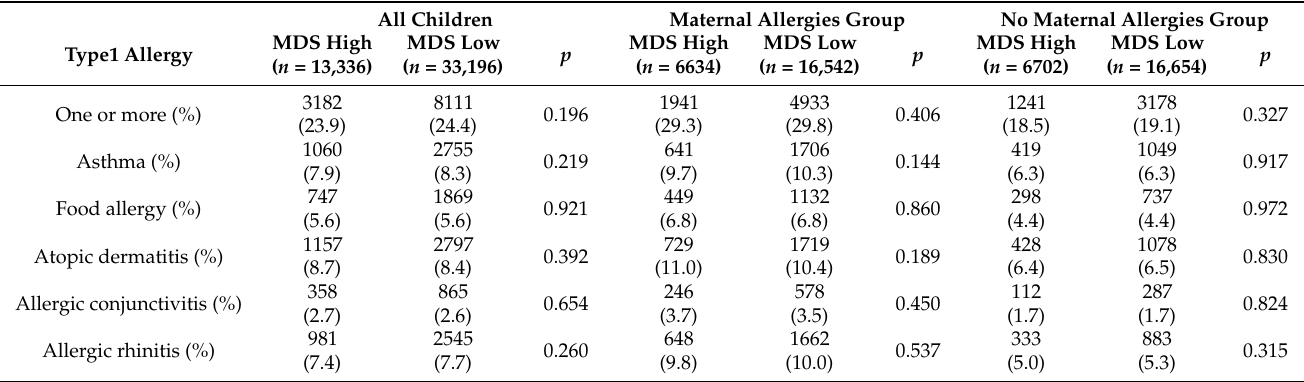
Table 2. Comparison of allergic outcomes between the two MDS groups. All Children Maternal Allergies Group No Maternal Allergies